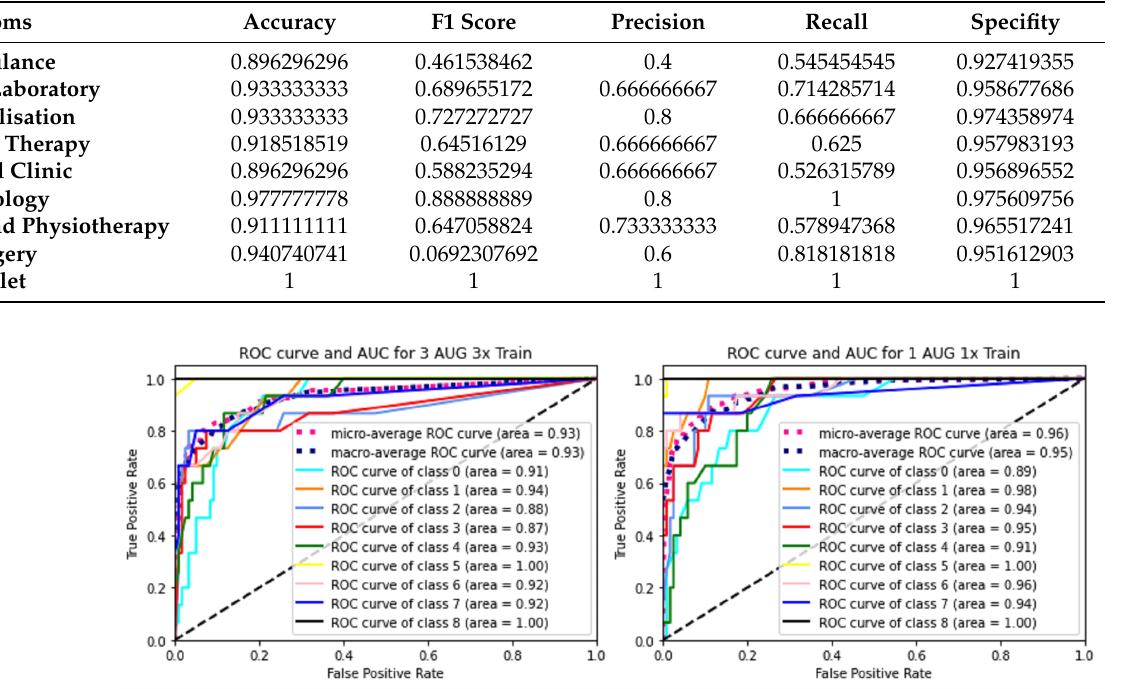
Table 20. Metrics of the RF classification algorithm obtained with the second version of the second model. Each column refers to a different metric, as defined in Section 2.4.2. Each row refers to a different IU.